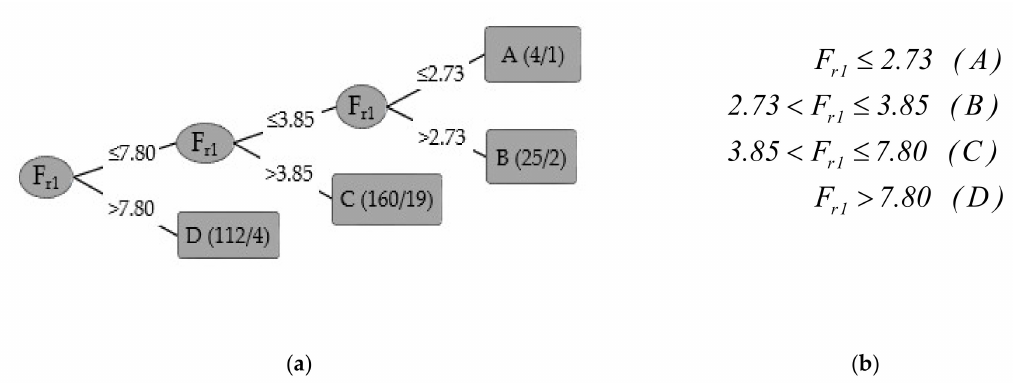
Figure 3. Decision tree and classification chart of the hydraulic jump in an artificial rough bed: ( a ) Decision tree classifier model (the numbers in brackets (e.g., 4 / 1 for class A) stands for the total number of data (e.g., 4) and the false classifications (e.g., 1) falling in each class, respectively), ( b ) classification chart.